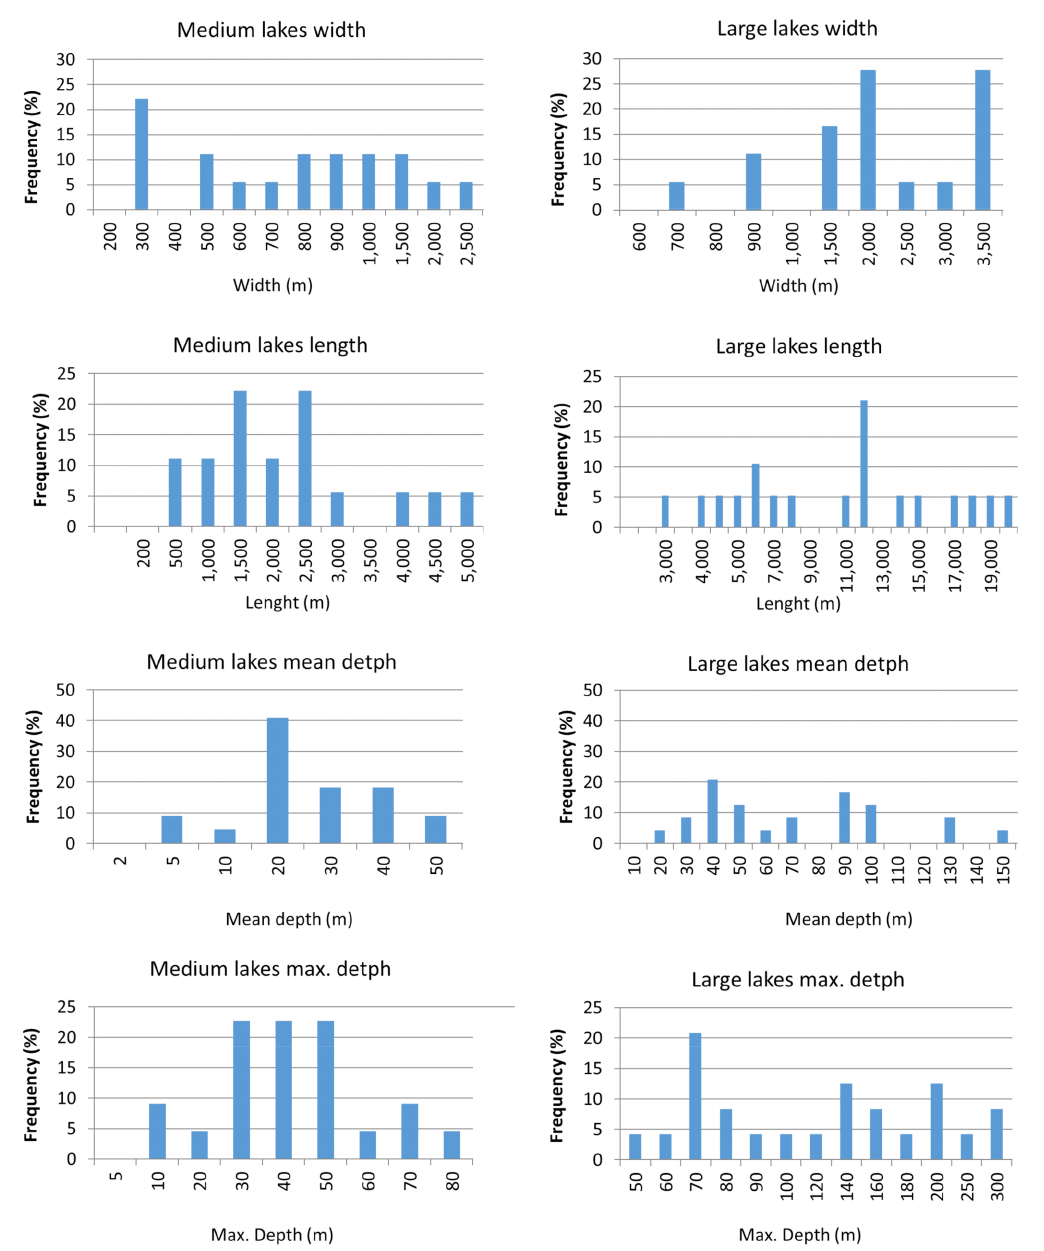
Figure 3. Frequency analysis and related histograms of geometrical characteristics (lake width and length, mean and maximum depth) of medium- and large-size